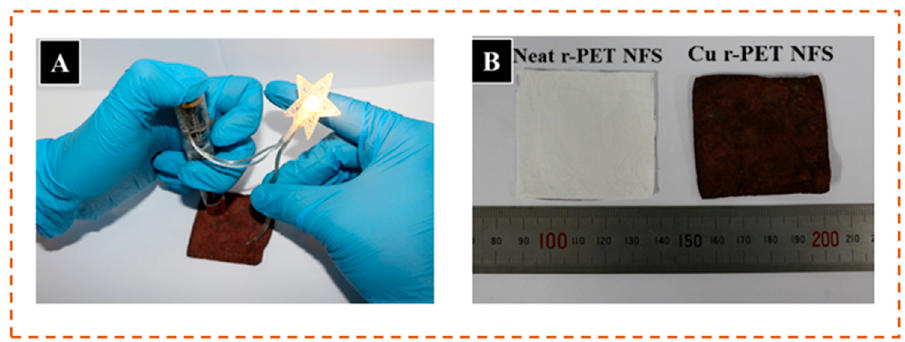
Figure 7. ( A ) Conductivity of r-PET NFS ( B ) results of copper-coated r-PET NFS after the ELD process.